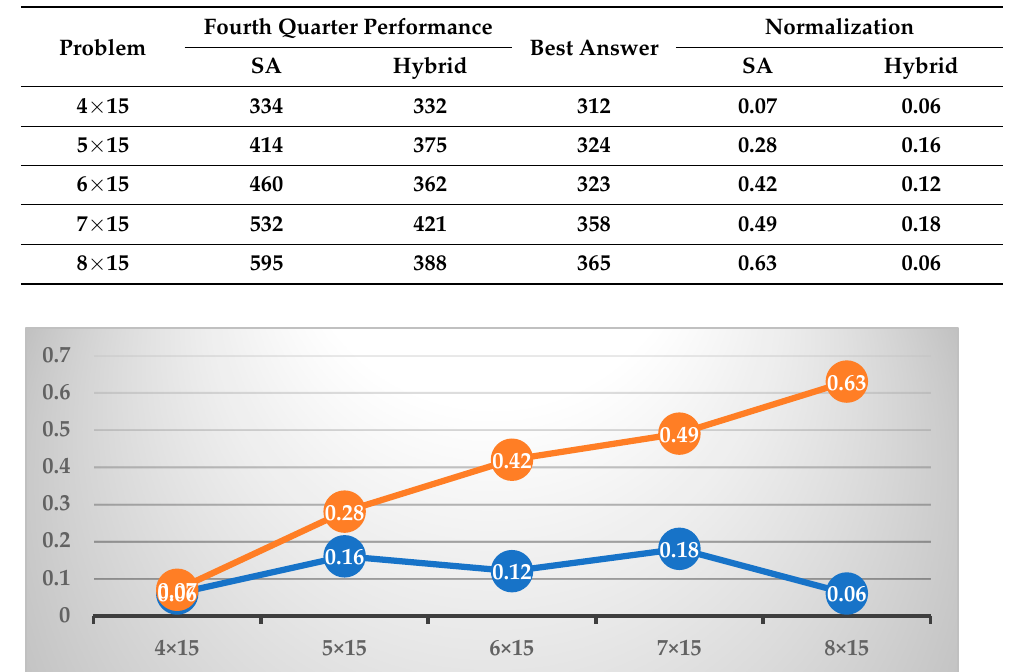
Figure 20. Fitness diagram of SA and hybrid SA in the fourth quarter (15 ORs).